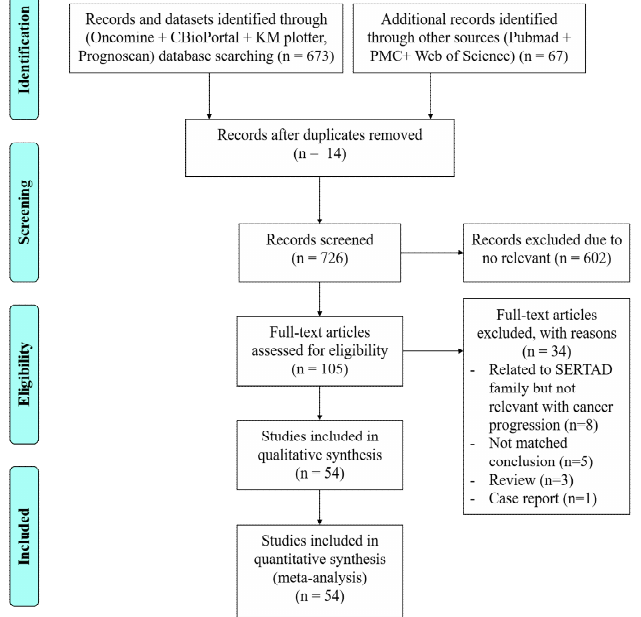
Figure 1. Flow chart of the selection process for the eligible studies for SERTAD1 retrospective study.